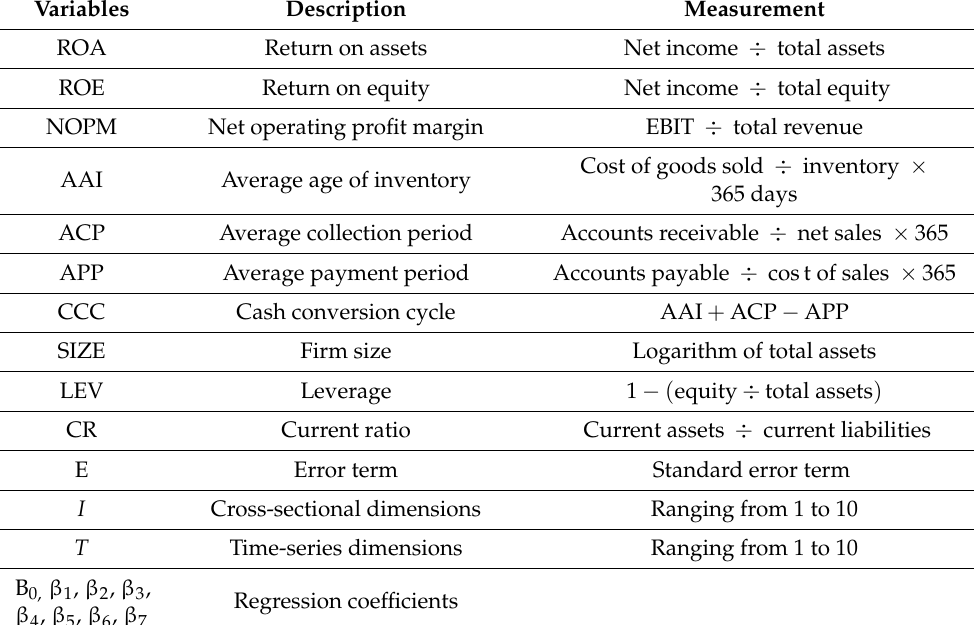
Table 1. Explanation of